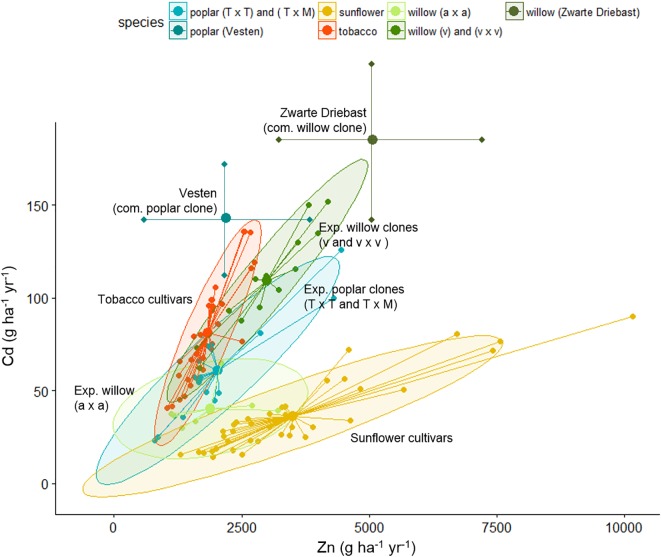
Cadmium and Zn extraction potential (g ha-1 year-1) of tobacco clones, sunflower mutants and poplar, willow clones evaluated on the experimental field. In case of tobacco and sunflower, extraction potential of identical clones/mutants were averaged over 2 years. Each clone is shown as a dot, connected with the spider-lines, and the overall average per group is indicated with the thick dot. Groups are colored, based on 90% ellipses. In case of commercial poplar and willow clones, results reflect data from Table 3.